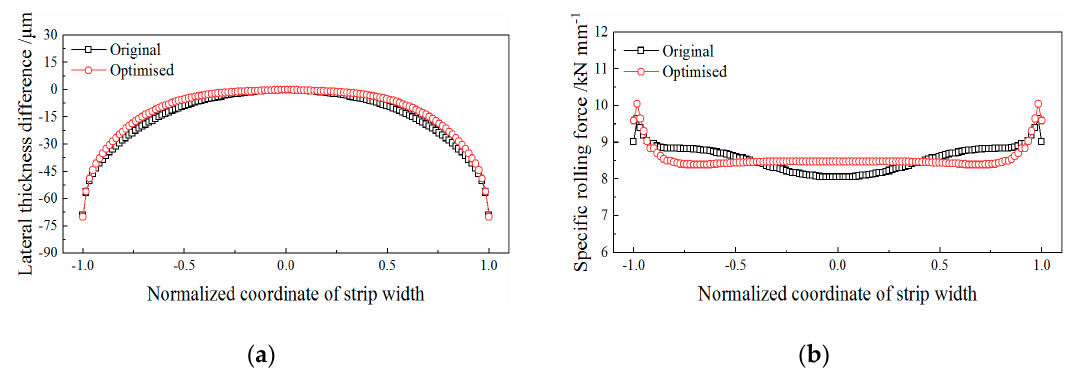
Figure 24. Comparison of calculation results before and after the optimisation ( Δ T = 100 °C, quartic crown is 8 µ m): ( a ) lateral thickness di ff erence of the strip; ( b ) specific rolling force.